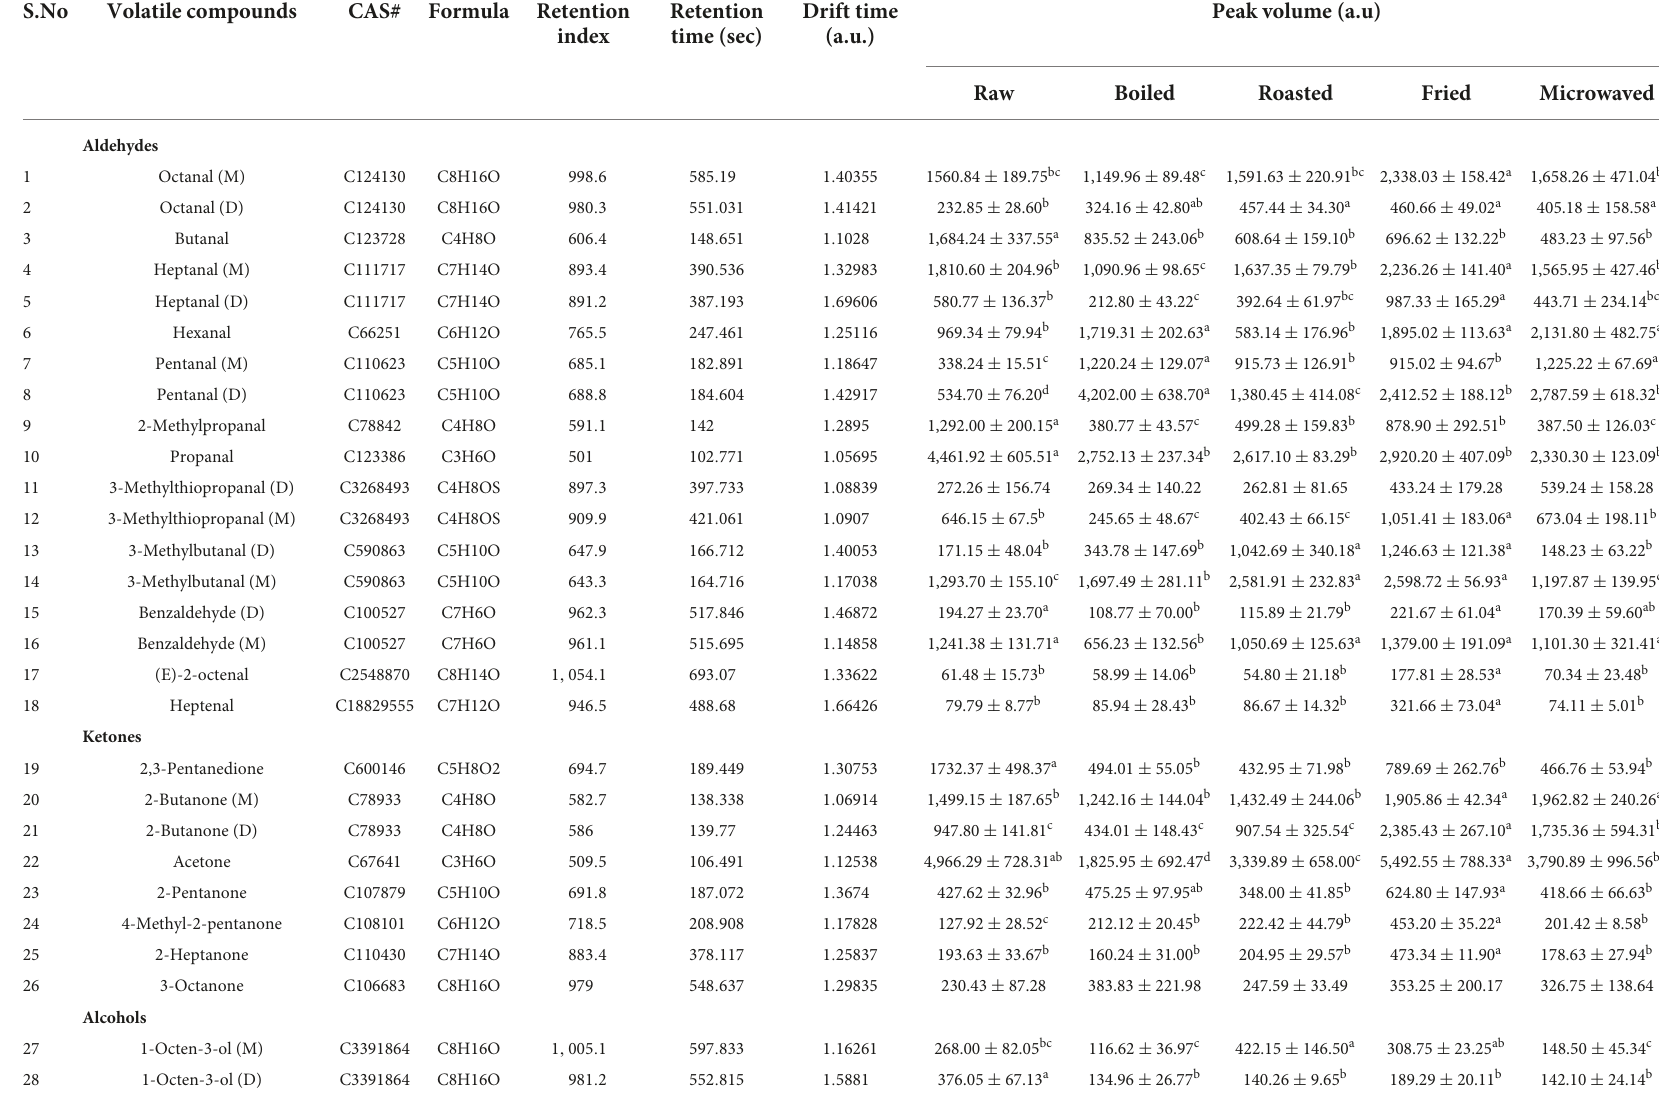
TABLE 1 Contents of volatile compounds in scallops identified by